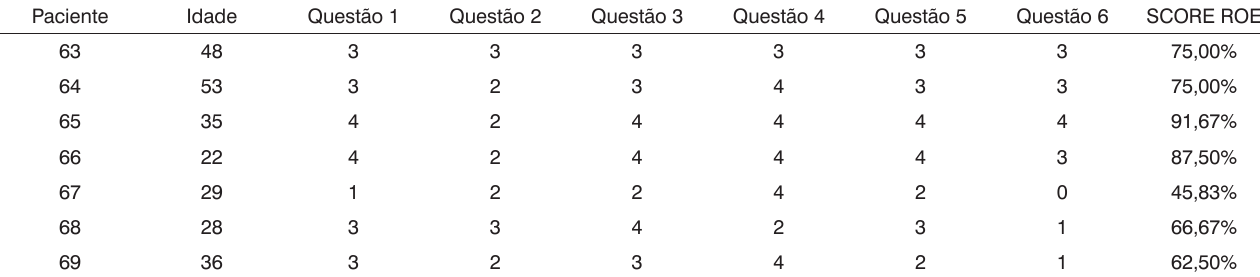
Tabela 2. Pacientes submetidos à rinoplastia